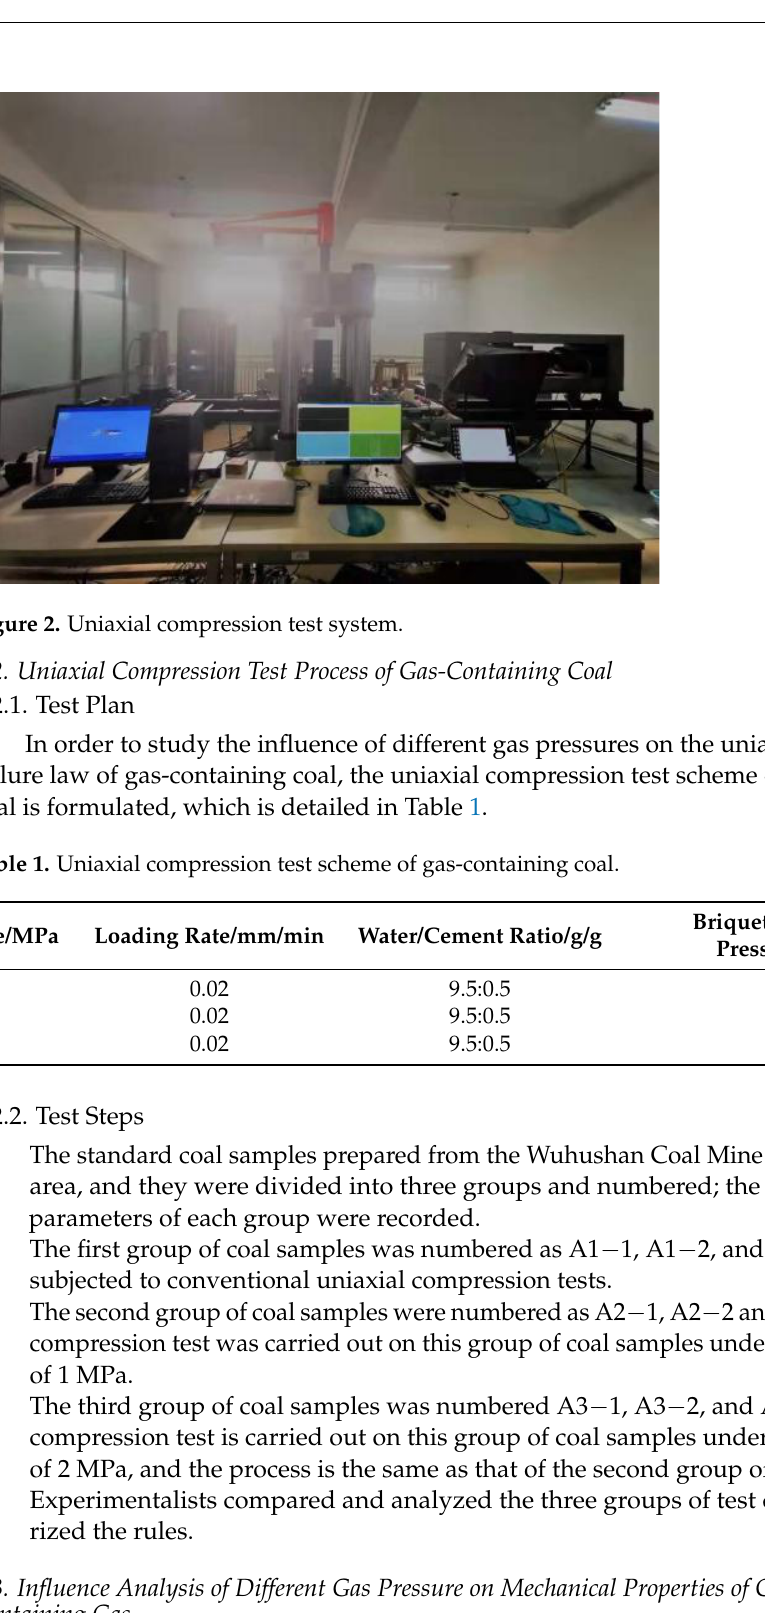
( b ) Figure 1. Briquette mold and briquette sample: ( a ) coal mold; ( b ) partial briquette coal sample.